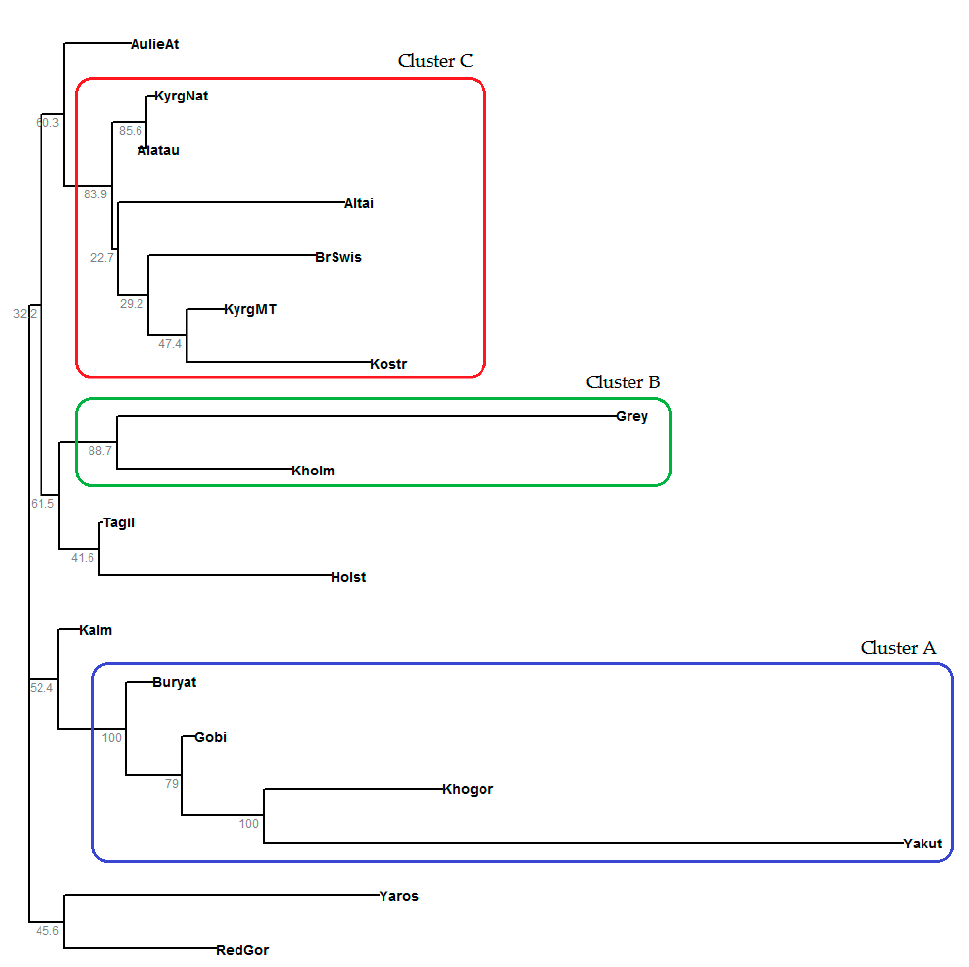
Figure 3. Phylogenetic tree constructed by the neighbor-joining algorithm using Nei’s genetic distances. Numbers at the branch nodes indicate the confidence values for each branch obtained using the bootstrap procedure. The red, green, and blue rectangles show three clusters of the livestock breeds with BS > 80%.